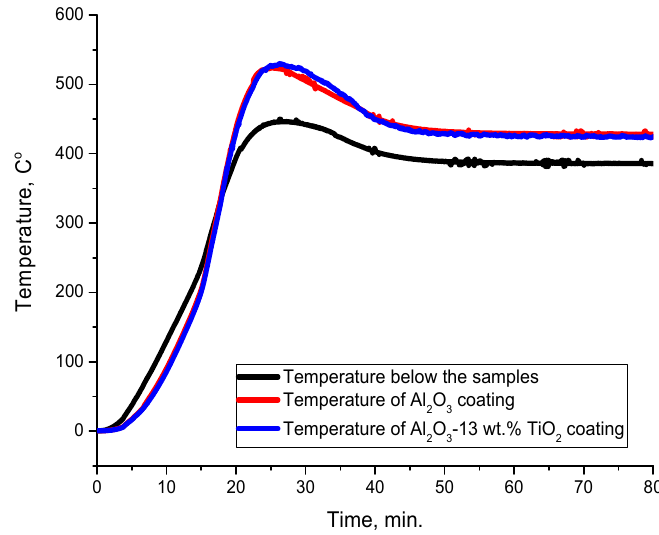
Figure 6. Temperature measured by thermocouples in a metal